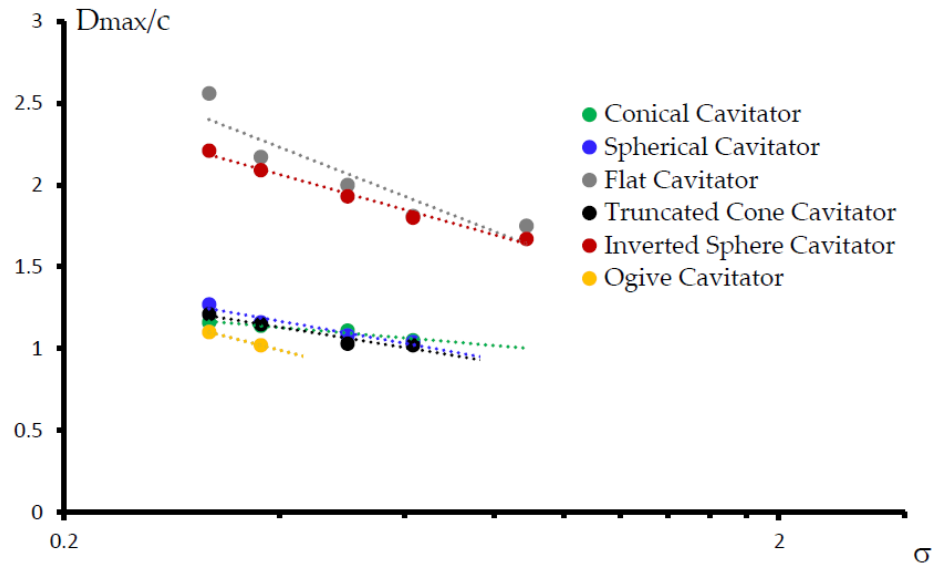
Figure 7. The bubble maximal diameter (in multiplies of body diameter) vs. the cavitation number for the six cavitators.